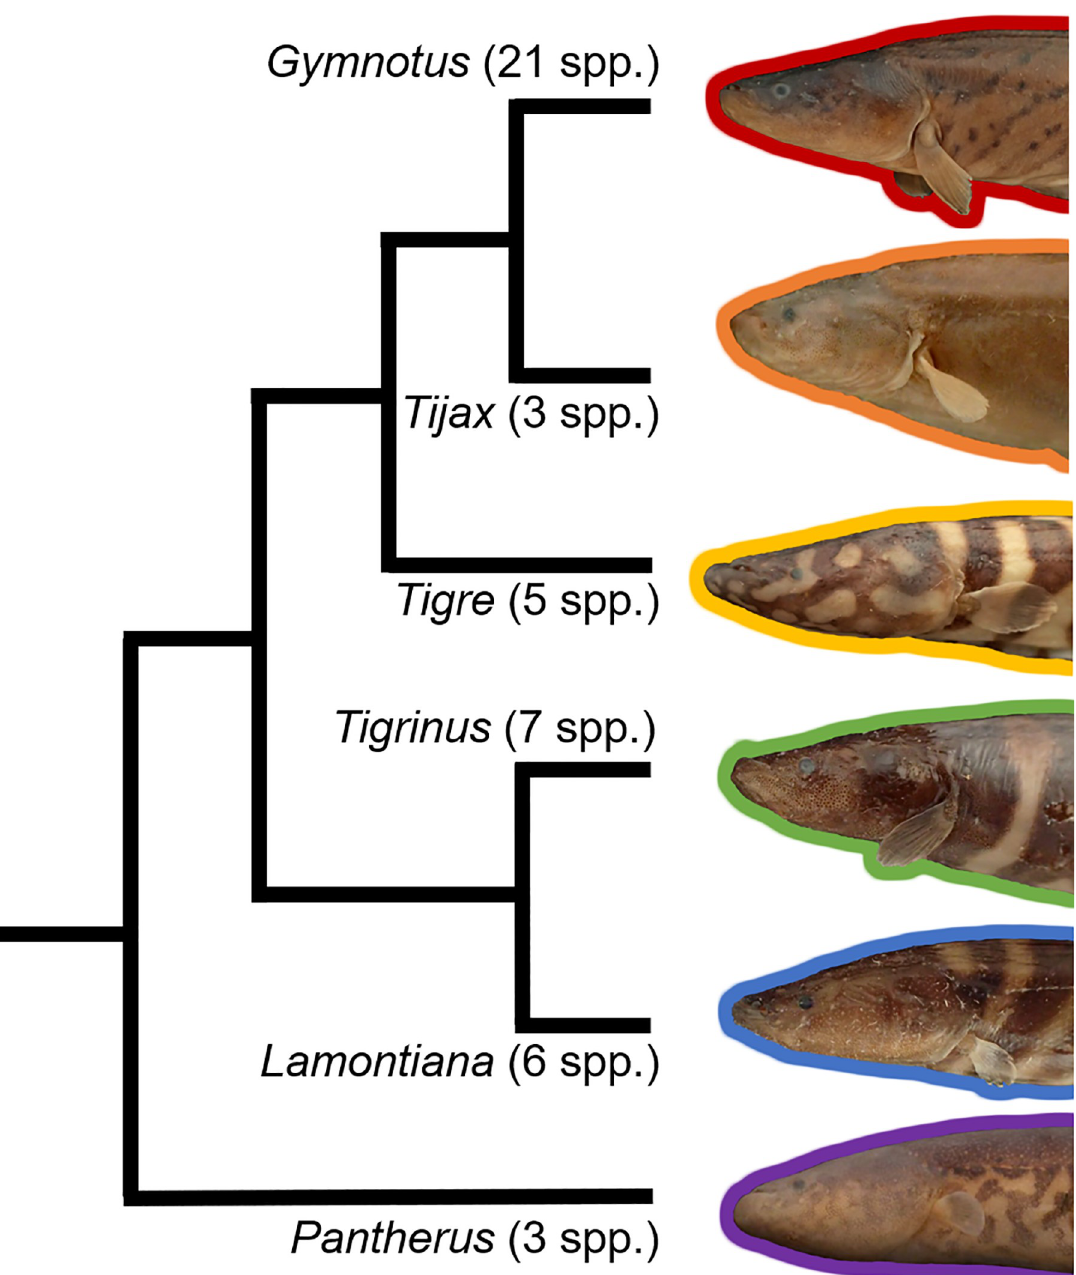
Fig 5. Summary of the relationships among subgenera of the Gymnotinae. Numbers in parentheses indicate number of currently recognized (valid) species.